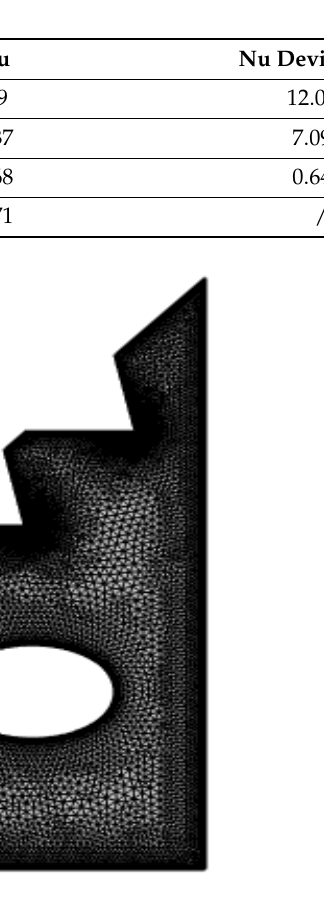
Figure 2. Mesh of the physical model.